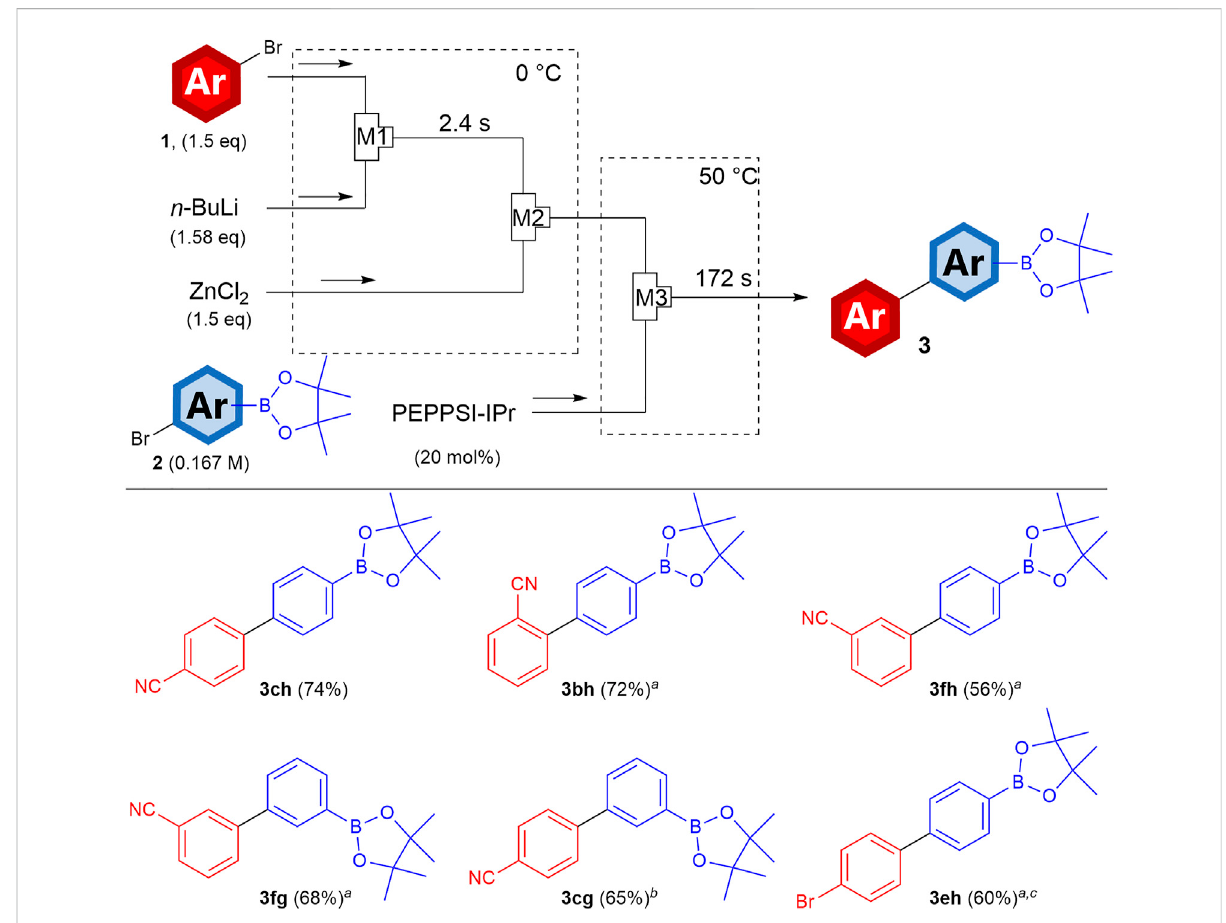
FIGURE 2 Schematic for metal-selective cross-coupling in fl ow microreactor. Yields were determined by GC. a Additional stirring in batch for 30 min b Additional stirring in batch for 12 h at 50 ° C, c Aryl iodide was used as the coupling partner, and Pd(PPh 3 ) 4 was used as the catalyst. 0.75 eq of ZnCl 2 was used. For the coupling, the temperature was 20 ° C and the residence time was 131